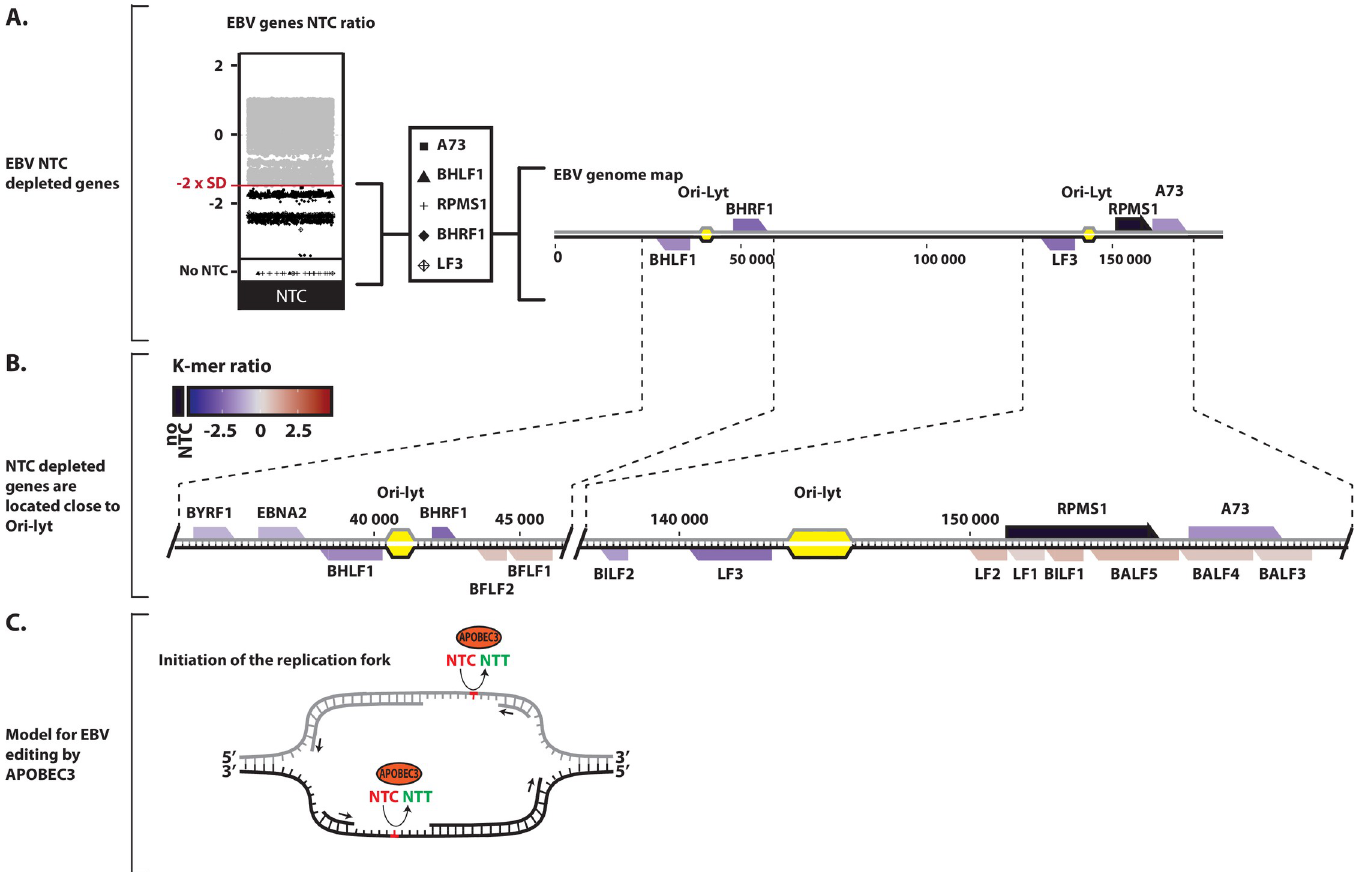
Fig 9. A3 footprint at the lytic replication origins of EBV. A. NTC observed/expected ratios were calculated for the different genes of EBV (each point represents a unique coding sequence) and the five most A3-footprinted genes were highlighted and positioned on the EBV genome map. B. Zoom-in detailing the NTC ratios of the genes surrounding the Ori-Lyt (lytic origin of replication) of EBV. A colored scale with increasing shades of blue indicating NTC depletion and increasing shades of red indicating NTC enrichment. C. Proposed model for A3-editing activity favoring the lagging strand at the EBV lytic origin of replication. A3-favored NTC sequence is represented in red and the NTT edited product in